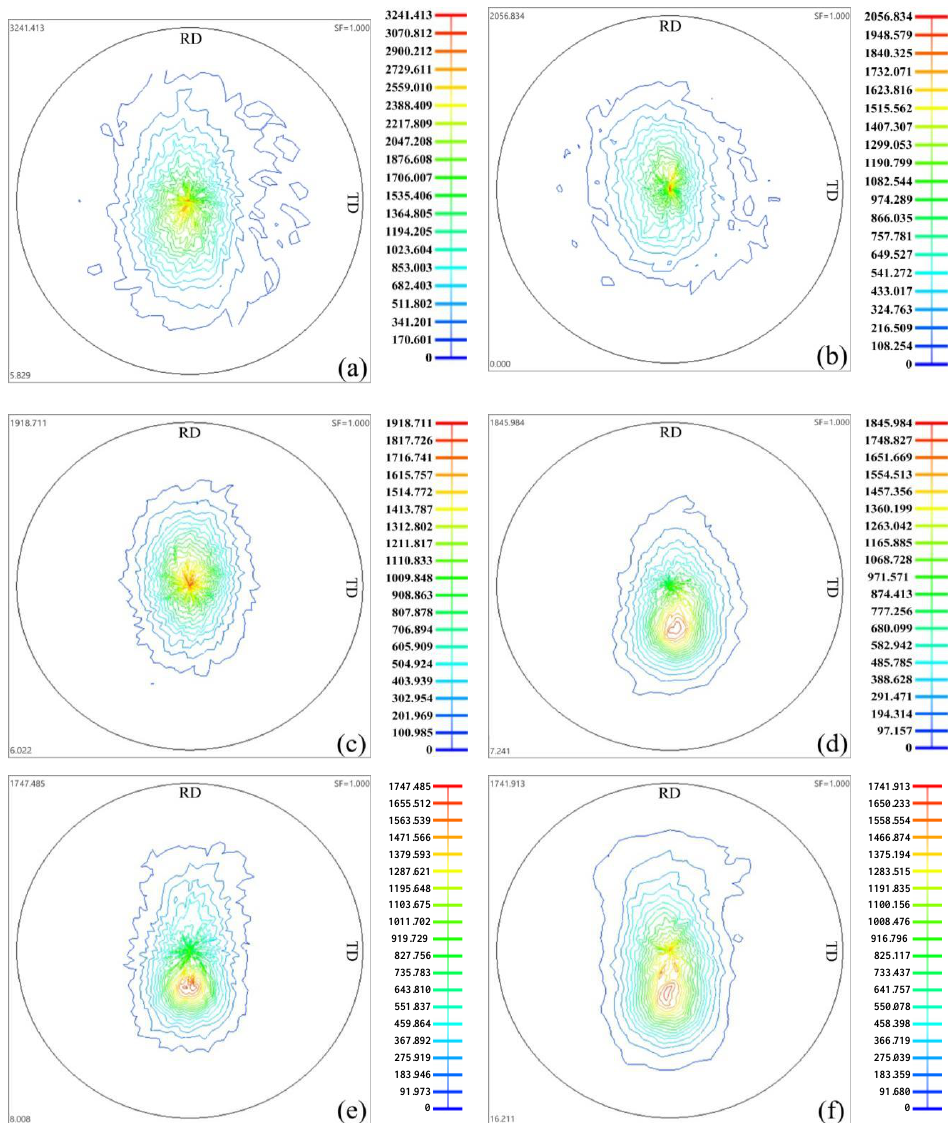
Figure 7. (0002) pole figure of AZ31 alloys HSRBFed to different accumulated strains ( a ) 0.22, ( b ) 0.44, ( c ) 0.66, ( d ) 0.88, ( e ) 1.1, ( f ) 1.32.